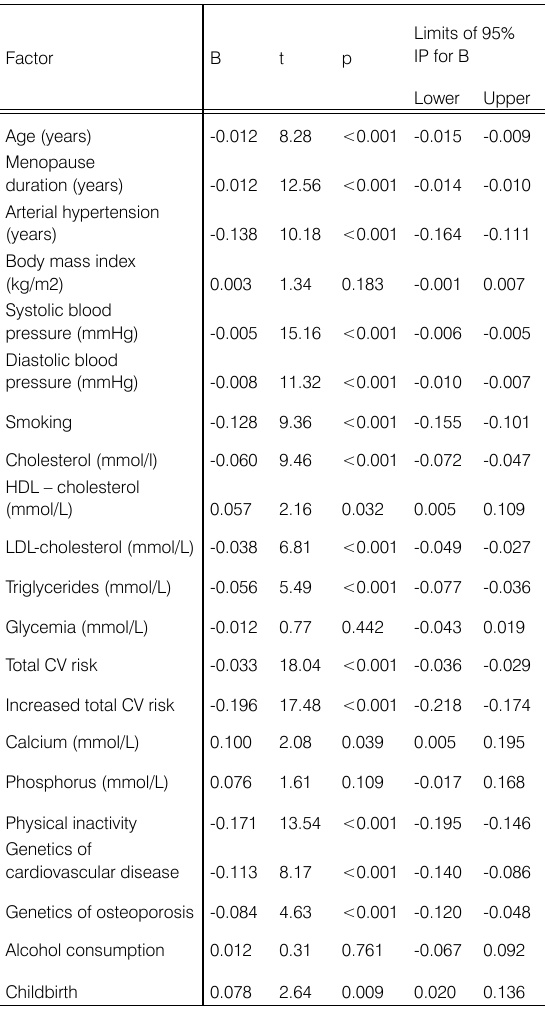
Table 2. Influence of risk factors on bone density; results of univari- ate linear regression analysis